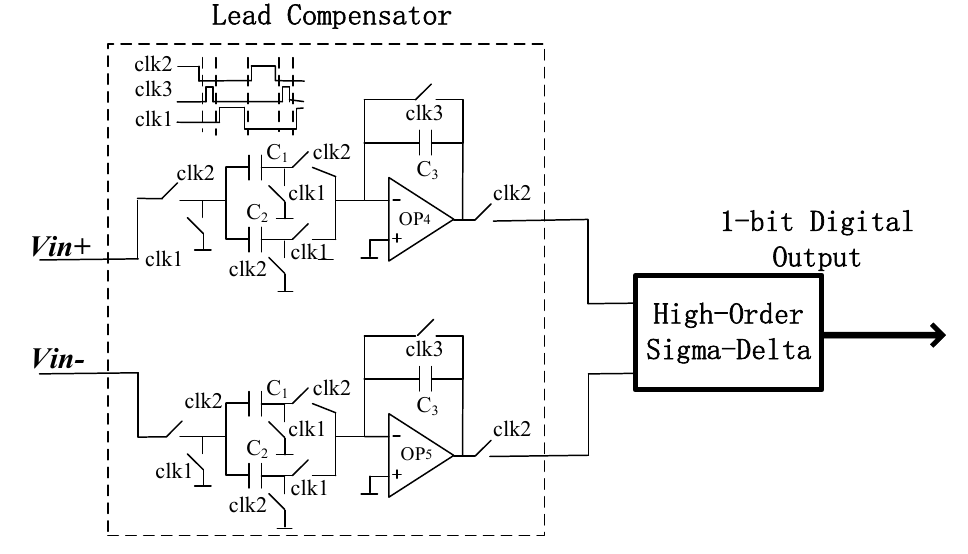
Figure 4. Lead compensator circuit.